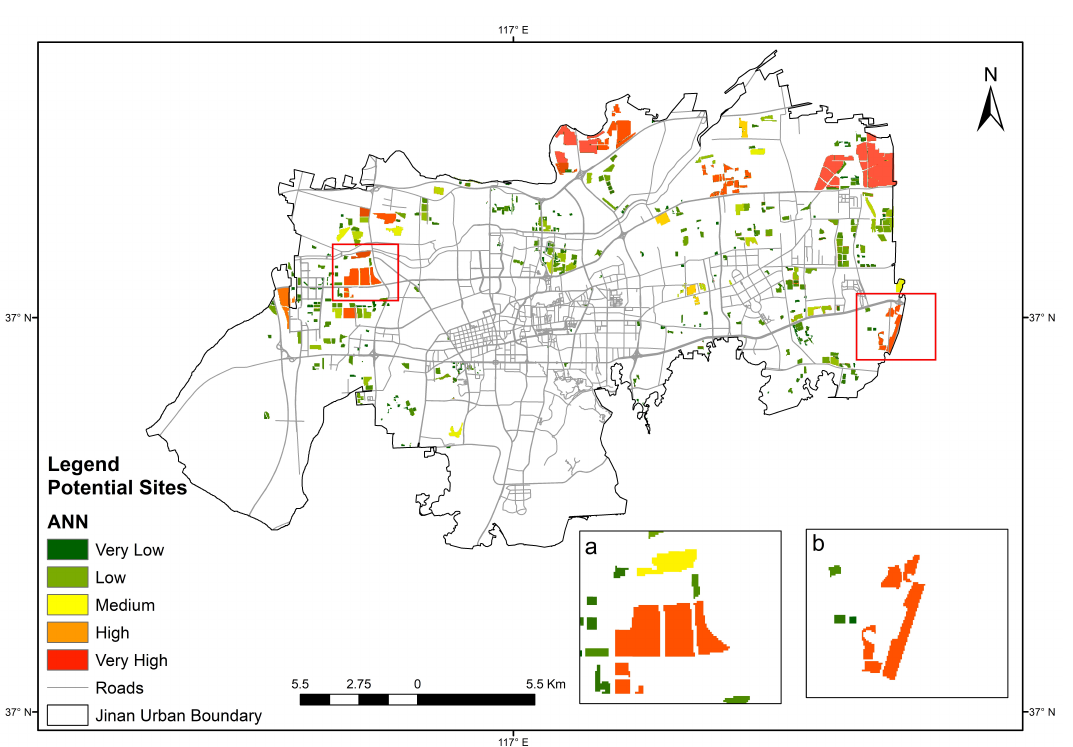
Figure 10. GI development potential sites mapping by ANN model :(bottom right) ( a ) West and ( b ) East of Jinan likely to be converted into